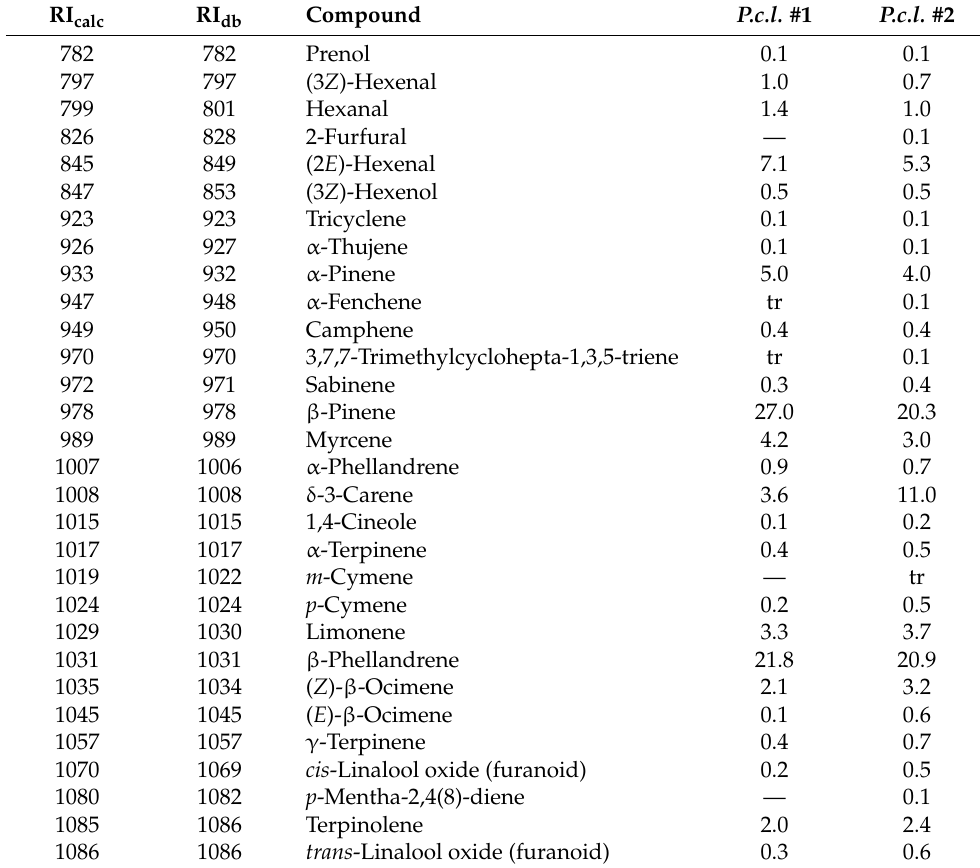
Table 3. Leaf essential oil compositions (percent) of Pinus contorta subsp. latifolia from southern